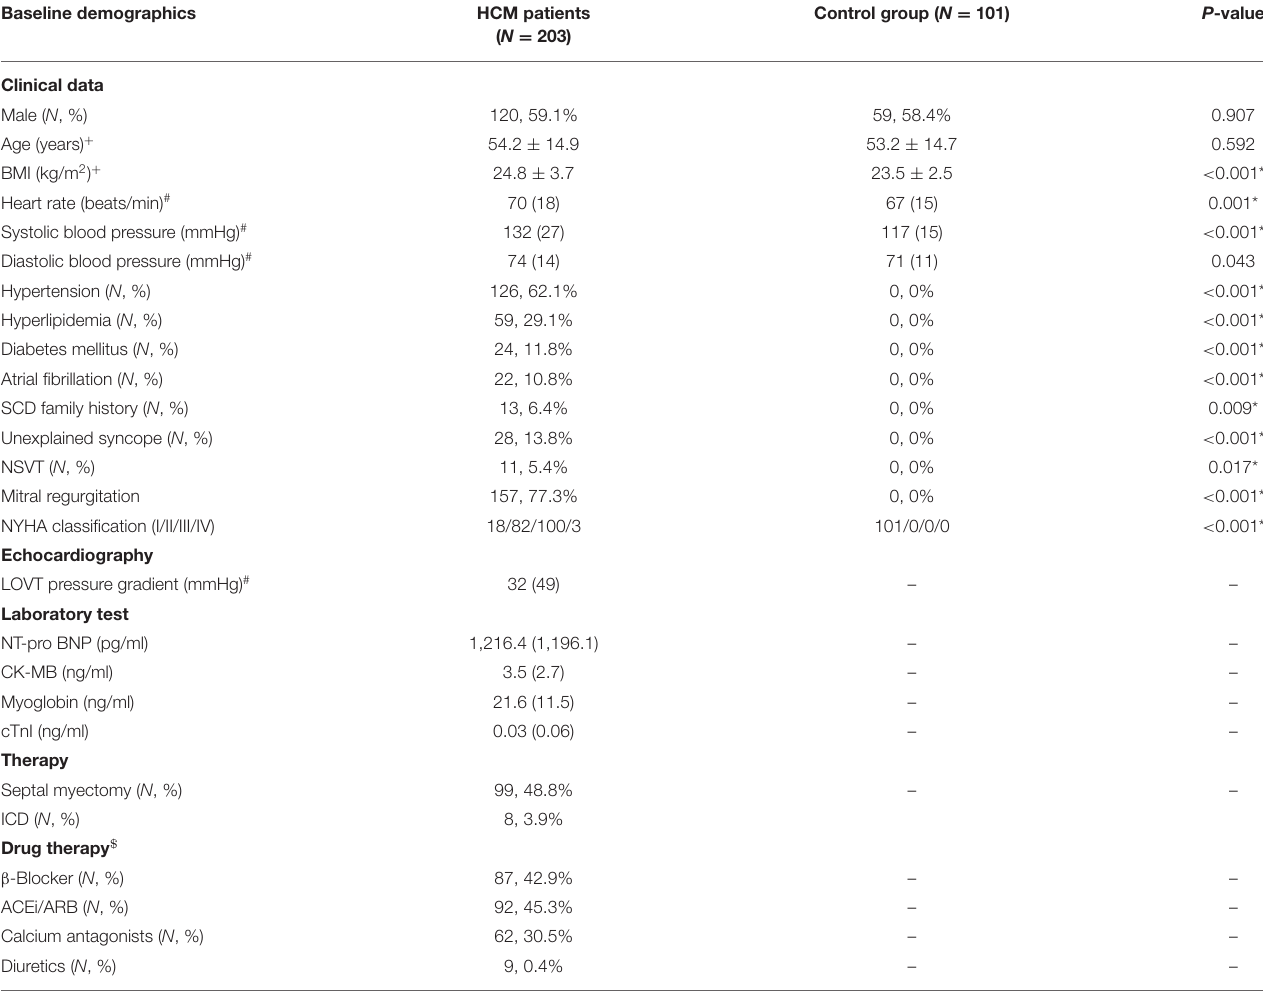
TABLE 1 | Baseline demographics of HCM patients and healthy